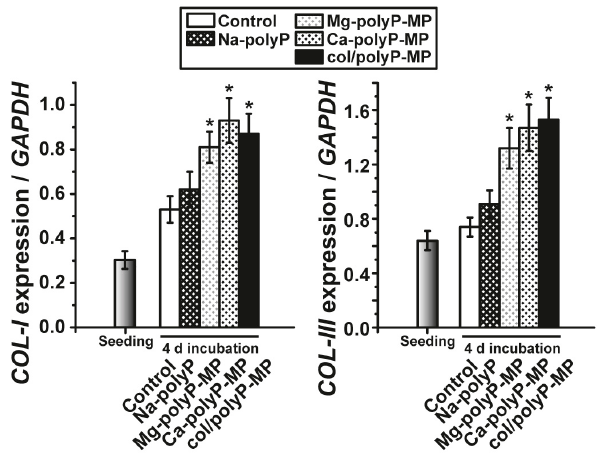
Figure 6. Gene expression levels of the two collagen types, collagen type I (COL-I), and collagen type III (COL-III) in MC3T3-E1 cells exposed to 50 µg/mL of “Na–polyP”, “Mg–polyP-MPs”, “Ca–polyP-MPs” or “col/polyP-MPs”; the controls received no additional component. After the 4-day incubation period the cells were harvested, their RNA was extracted and the steady-state levels of collagen expression were determined by qRT-PCR. The expression levels at time 0 (seeding) and time 4 days are correlated with the one of the housekeeping genes GAPDH . * p < 0.01 ( n = 6 parallel experiments; Student’s t -test) with respect to the values of the controls.